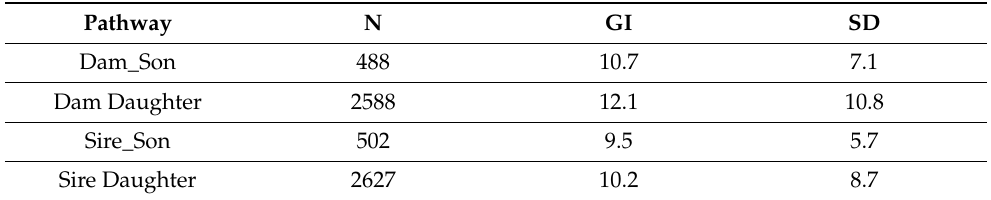
Table 5. Average generation intervals (GI) and standard deviations (SD) expressed in years for the four parent–offspring pathways in the whole pedigree of the MH.